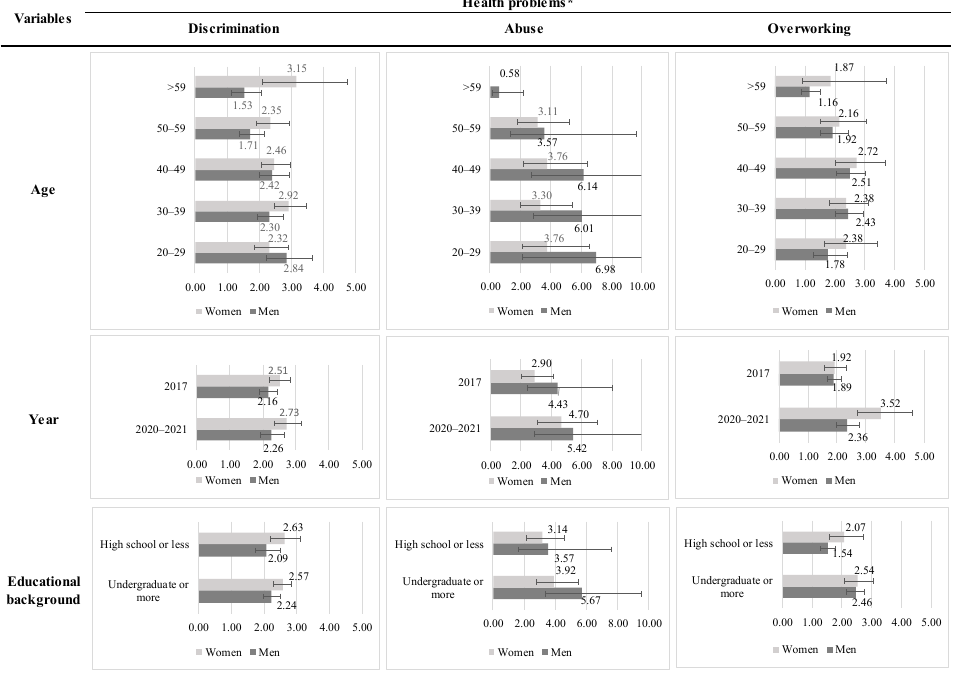
Figure 2. The result of the subgroup analysis was stratified by independent variables (age, year, and educational